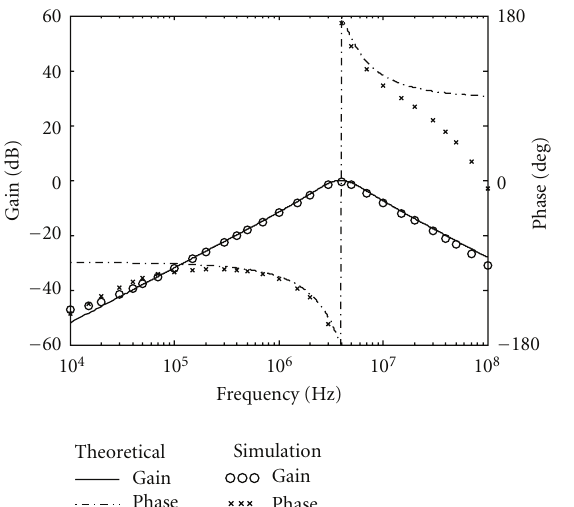
Figure 10: Simulation results of the proposed current-mode sec- ond-order bandpass filter.